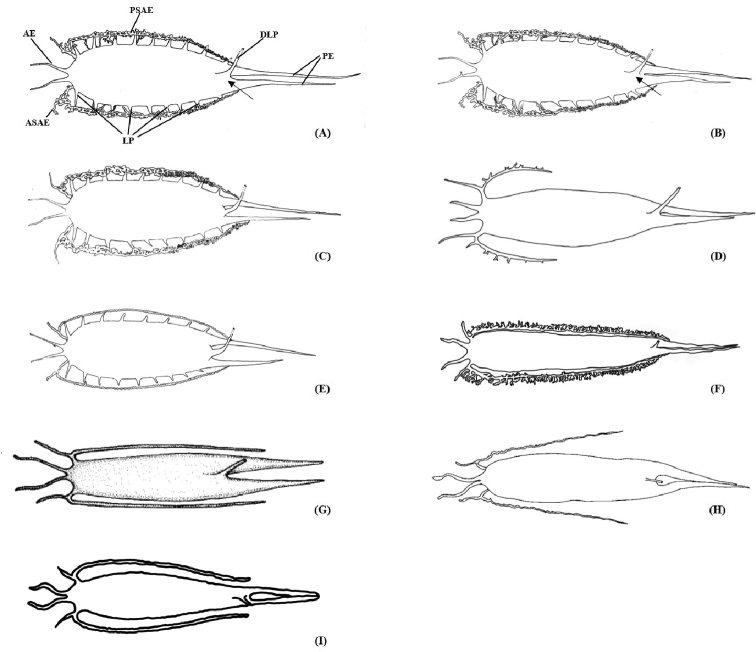
Swim bladders of nine Sillago species AS.
nigrofasciata sp. nov. BS.
sihamaCS.
shaoiDS.
sinicaES.
indicaFS.
parvisquamisGS.
intermedius (McKay 1992) HS.
caudicula (Kaga et al. 2010) IS.
suezensis (sketch based on Golani et al. 2014). AE, anterior extension; ASAE, anterior sub-extension of anterolateral extension; PSAE, posterior sub-extension of anterolateral extension; LP, lateral processes; DLP, duct-like process; PE, posterior extension. Black arrows indicate differences between S.
nigrofasciata sp. nov. and S.
sihama.